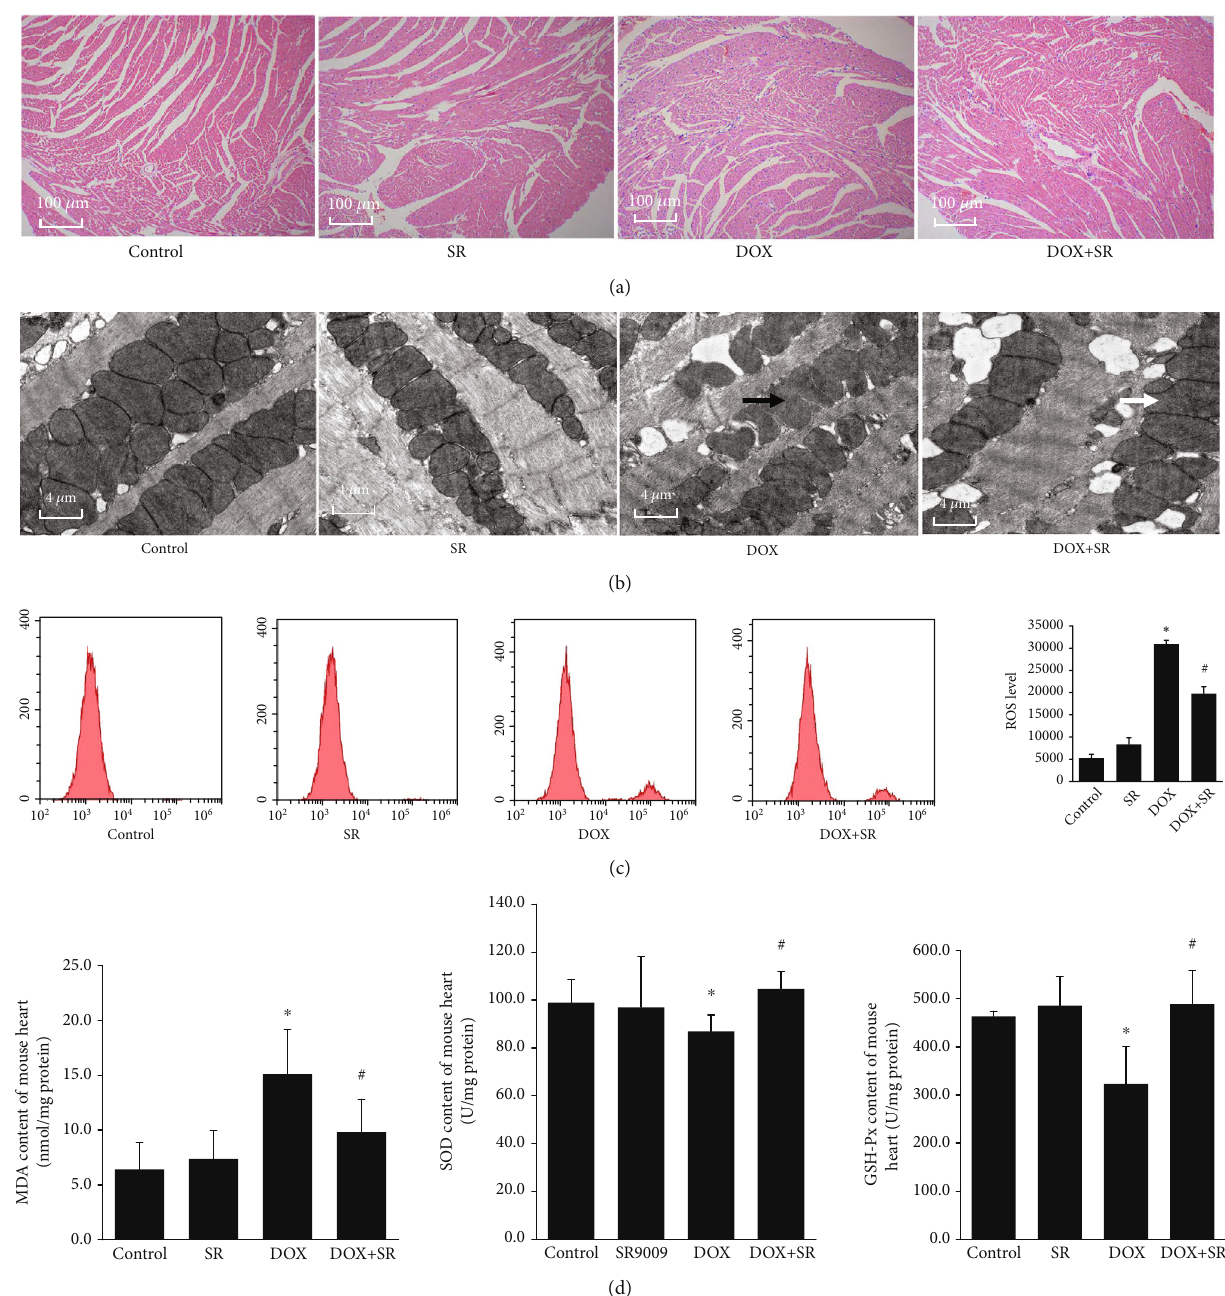
Figure 4: E ff ects of SR9009 on cardiotoxicity in doxorubicin-treated mouse heart. (a) Representative HE staining images of left ventricle. Scale bar: 100 μ m. (b) Representative ultrastructural morphology images of mitochondria of left ventricle. Scale bar: 4 μ m. Black arrows: swollen mitochondria with cristae disorientation and breakage; white arrowheads: normal mitochondria. (c) Representative ROS generation of heart tissue analyzed by fl ow cytometry. The horizontal axis represents fl uorescent intensity, and the vertical axis represents cell count. (d) MDA content, SOD activity, and GSH-Px activity of heart tissue. The results are expressed as mean ± SD , n = 5 . ∗ Compared with the control group, P < 0 : 05 . # Compared with the DOX group, P < 0 : 05